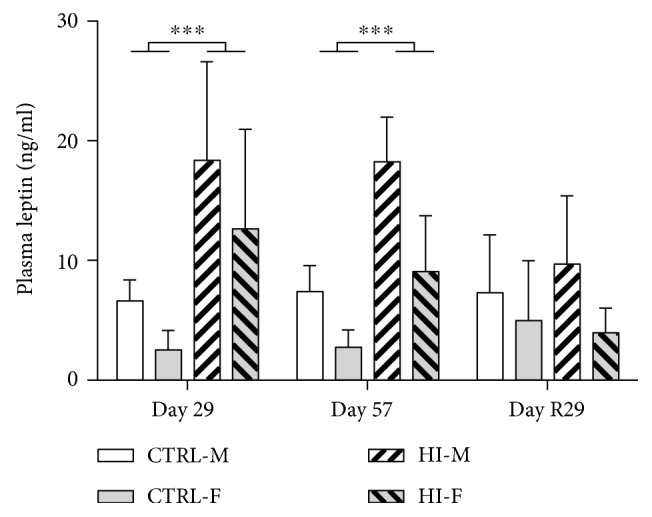
Plasma leptin levels, mean + SD. CTRL-M: n = 7 − 10, HI-M: n = 4 − 8, CTRL-F: n = 8 − 10, and HI-F: n = 6 − 9. At all three time points, males had significantly higher leptin levels compared to females (p = 0.0325, p < 0.0001, and p = 0.0182). ∗∗∗p < 0.001.